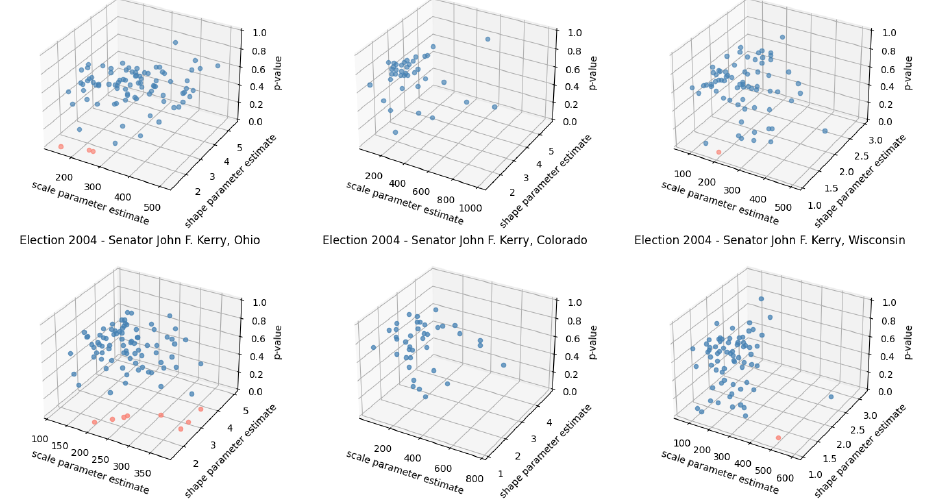
Figure 4. Discrete Weibull parameter estimation and Kolmogorov Smirnov Goodness of Fit Test Results for Ohio, Colorado, and Wisconsin, US 2004 Presidential Election. p -values above 0.05 (indicate conformance to discrete Weibull